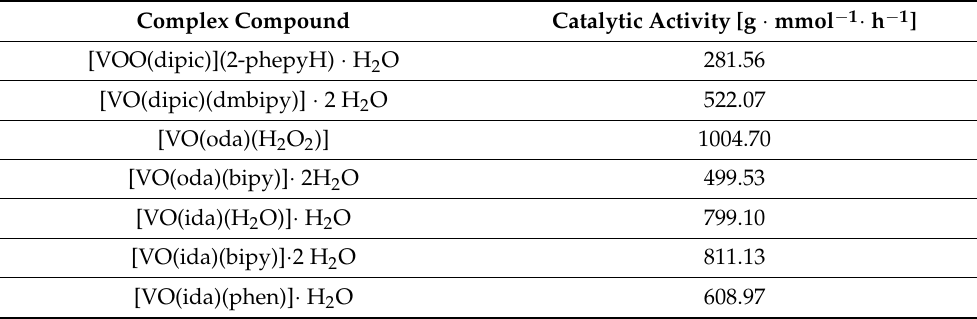
Table 1. Comparison of the catalytic activity values for the compounds included in the publication and the newly synthesized compounds.